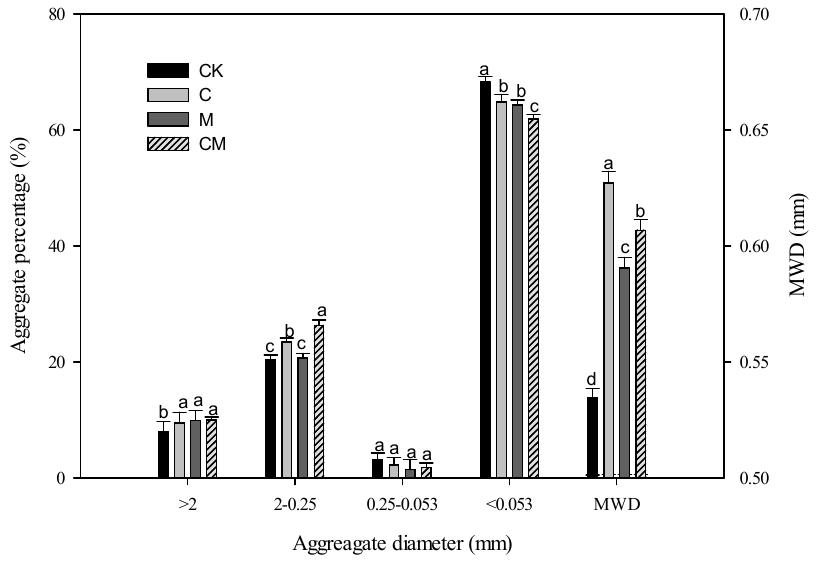
Figure 1. Effects of different treatments on the vertisol aggregate size distribution using wet sieving method and MWD, where error bars represent standard deviation and lowercase letters indicate significant differences between treatments ( p < 0.05).